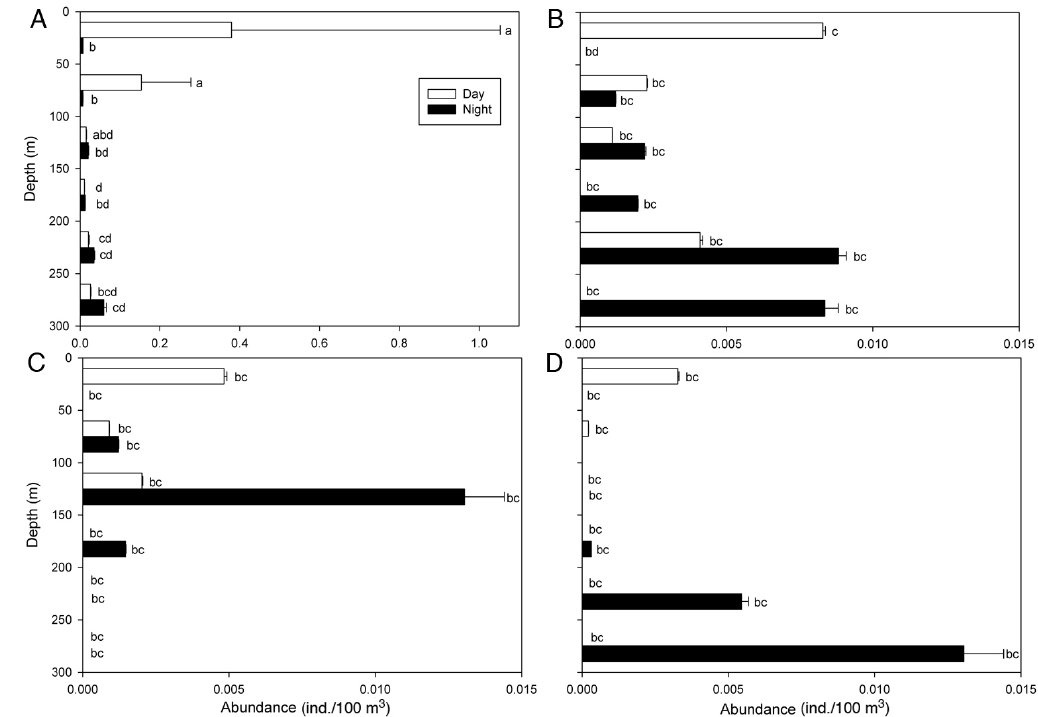
Fig. 3. – Monodaeus couchii . Abundance of larvae (ind./100 m 3 ±SE) with respect to depth for zoea I (A), zoea II (B), zoea III (C), and zoea IV (D) as a function of the phase of the day for the 2006 cruise. White and black bars represent day and night samples, respectively. At each depth, sample size was n=7 for the day, and n=10 for the night. Identical letters above bars represent statistically similar abundances according to post-hoc tests. The scale of abundance is different between zoea I and zoea II, III and